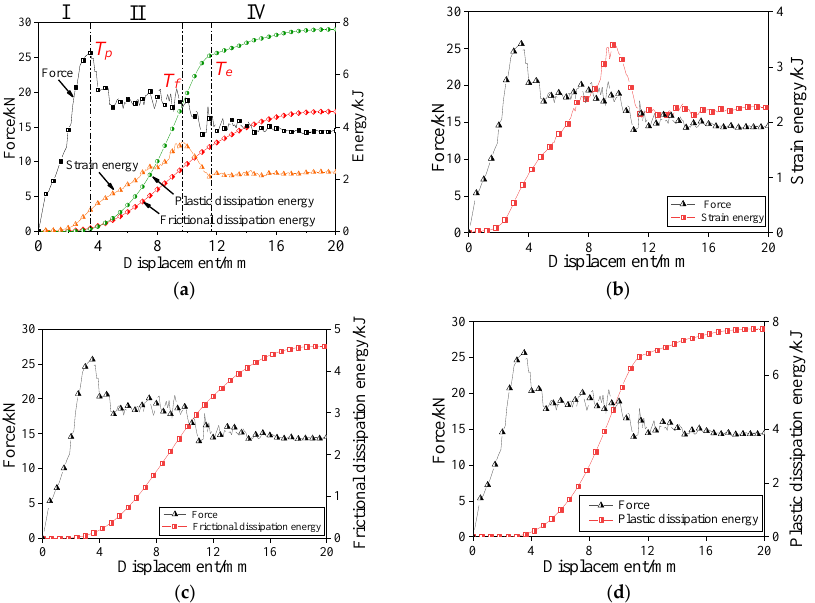
Figure 16. Evolution of the different energies ( T p is the peak point of the shear stress, T f is the end of the strain-softening phase, and T e is the plastic dissipative energy turning point): ( a ) displacement–force–energy; ( b ) displacement–force–elastic strain energy; ( c ) displacement–force–frictional dissipation energy; ( d ) displacement–force–plastic dissipation energy.